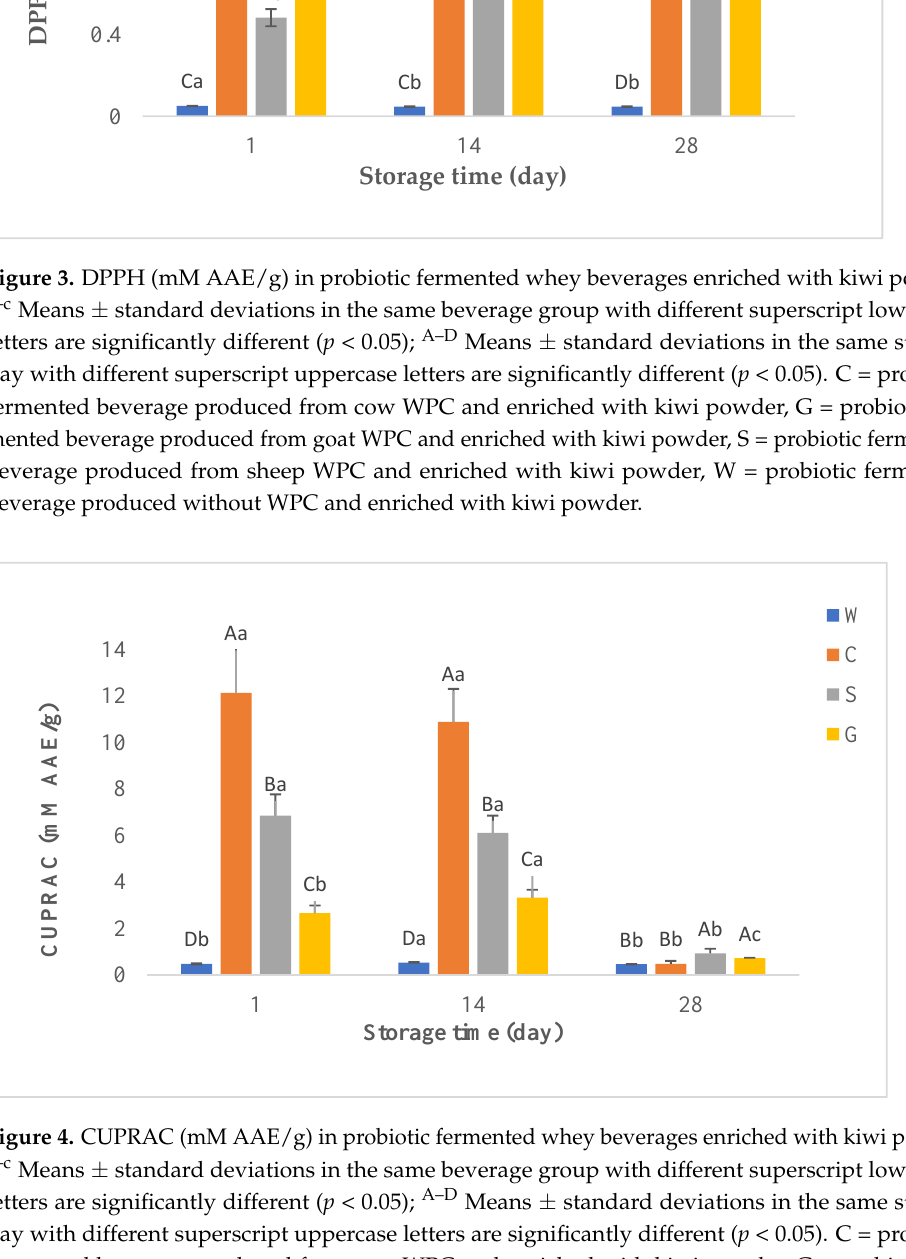
Figure 4. CUPRAC (mM AAE/g) in probiotic fermented whey beverages enriched with kiwi powder. a–c Means ± standard deviations in the same beverage group with different superscript lowercase letters are significantly different ( p < 0.05); A–D Means ± standard deviations in the same storage day with different superscript uppercase letters are significantly different ( p < 0.05). C = probiotic fermented beverage produced from cow WPC and enriched with kiwi powder, G = probiotic fermented beverage produced from goat WPC and enriched with kiwi powder, S = probiotic fermented beverage produced from sheep WPC and enriched with kiwi powder, W = probiotic fermented beverage produced without WPC and enriched with kiwi powder.